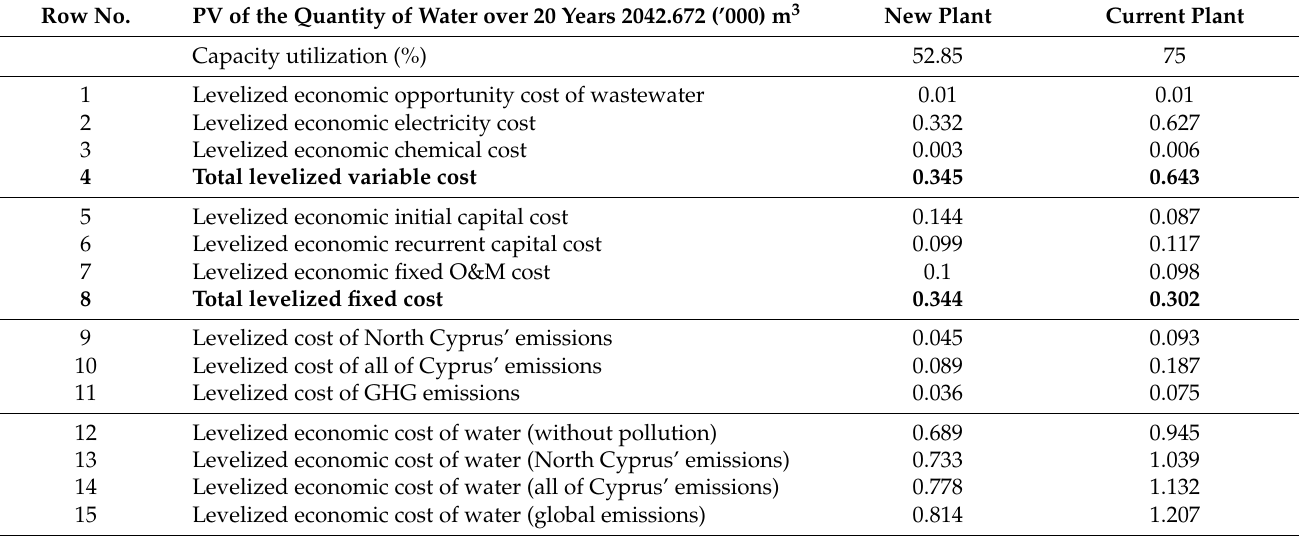
Table 12. Levelized economic costs (with diesel fuel generators) for the different levels of utilization (in 2022 prices), USD/m 3